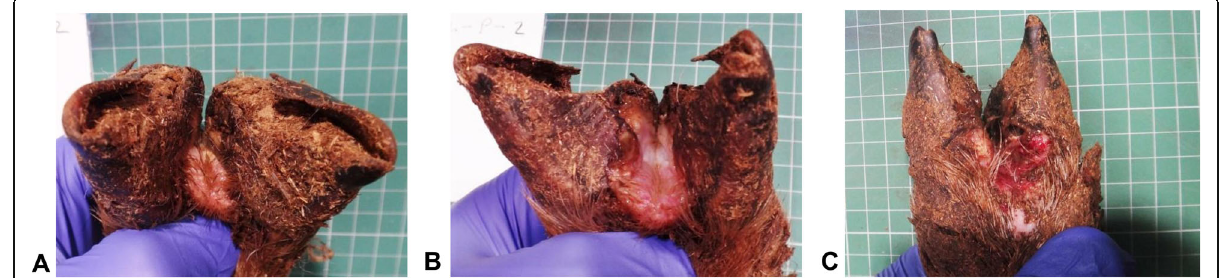
Fig. 1 Sheep foot lesions observed during the development of CODD. a Interdigital dermatitis lesion, b footrot lesion, c CODD